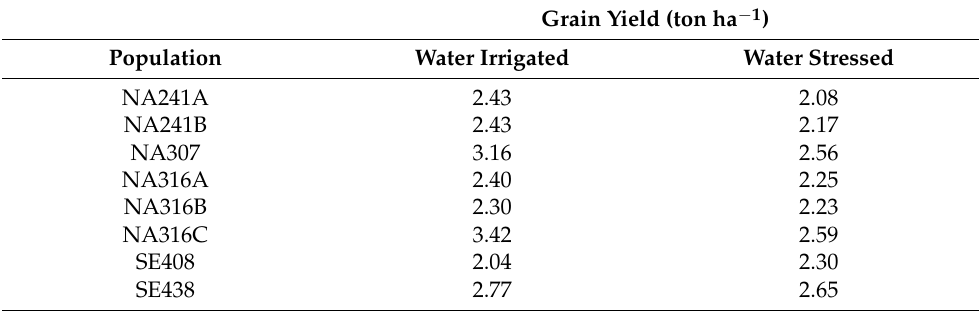
Table 2. Grain yield of sorghum genotypes under well-watered and water-stress